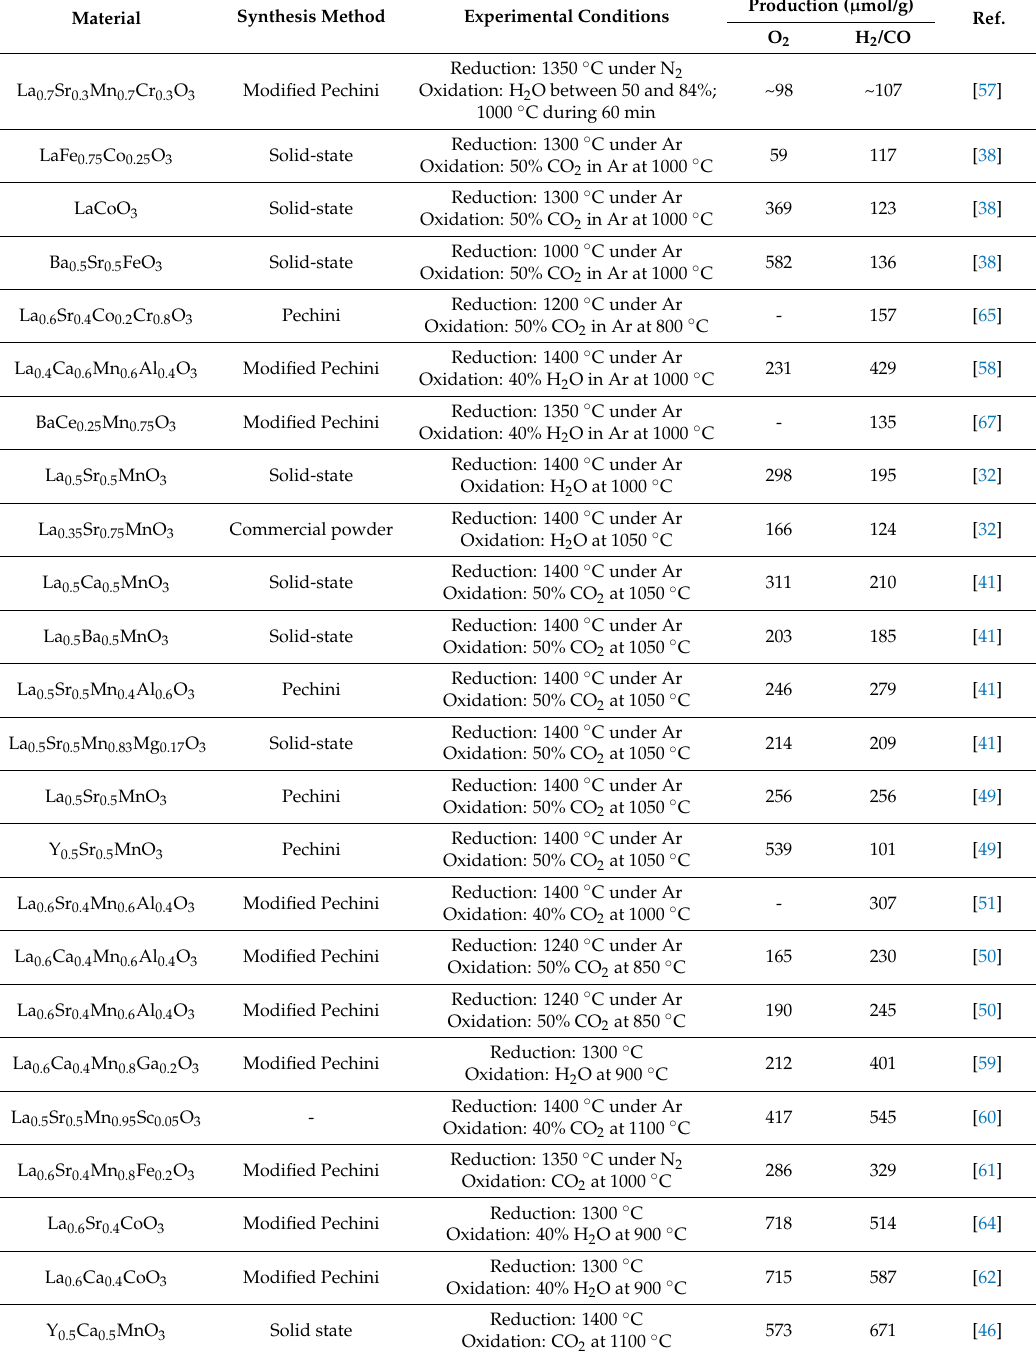
Table 1. Comparison of the performance of current perovskites studied for thermochemical